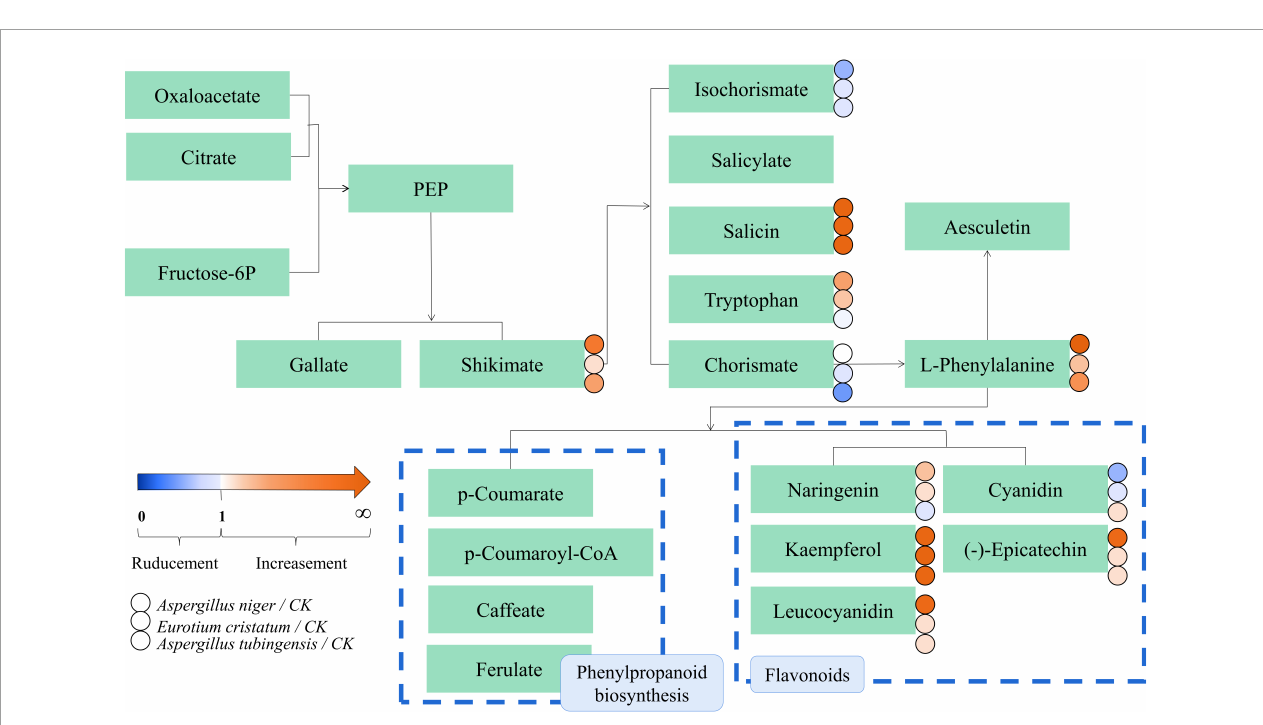
FIGURE5 metabolic pathway diagram of the differential metabolites in IDTs. The dots represent the relative content of metabolites between the IDT fermented by microorganisms and the bank control. The dots represent the relative content of metabolites between IDT produced by blank control and IDTs fermented by fungi. The color-coded scale grading from orange to blue represented the metabolites from high to low. The different fermentation treatments of instant dark tea were the blank control [A], Aspergillus niger [B], Aspergillus cristatus [C], and Aspergillus tubingensis [D].